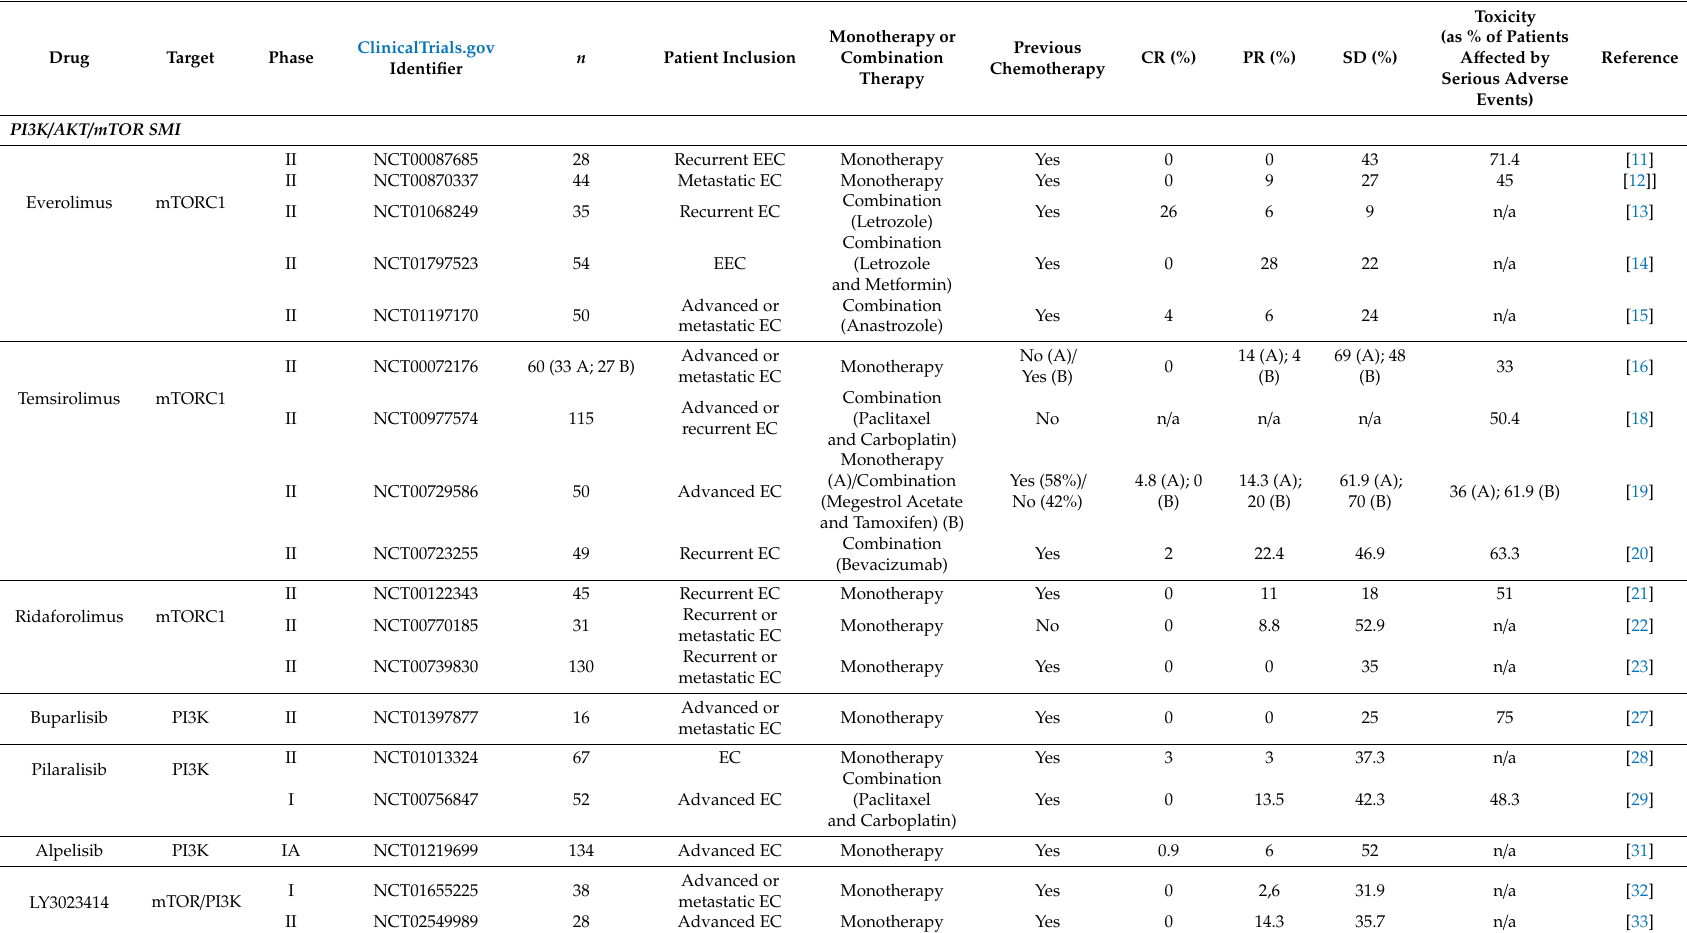
Table 2. Completed clinical trials of SMIs in